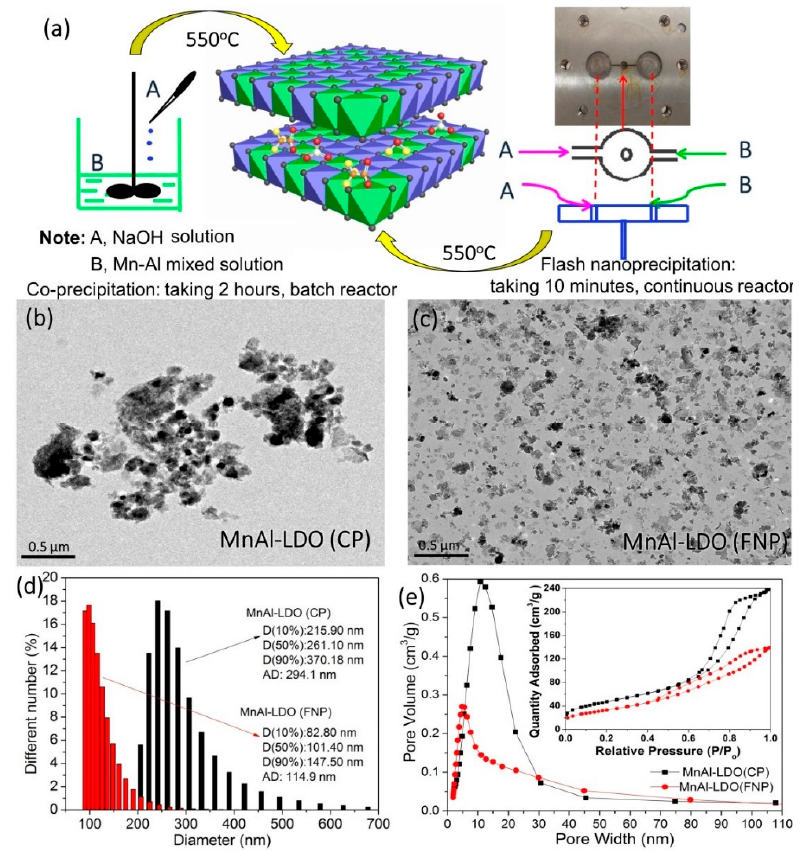
Figure 1. ( a ) The preparation schematic diagram; ( b , c ) Transmission electron microscopy (TEM) images; ( d ) Pore size distribution curves; ( e ) N 2 adsorption-desorption isotherms and pore size distributions of MnAl-LDO (MnAl-layered double oxide) (CP) and MnAl-LDO (FNP) catalysts.